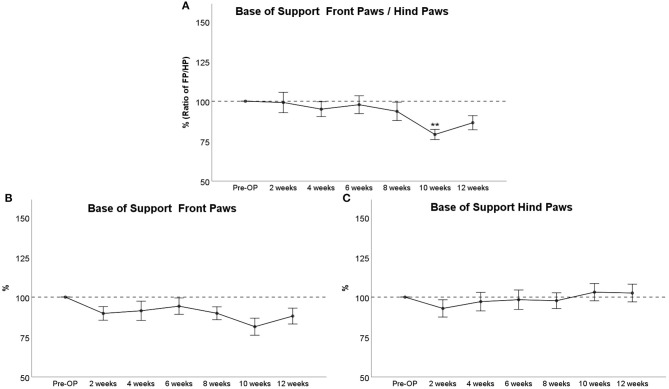
Course of Base of Support (BoS) prior to and following bilateral median nerve resection and unilateral autograft repair. The figures depict either the BoS Ratio between front paws and hind paws (A), the course of front paw BoS (B), or hind paw BoS (C), **p < 0.01 as compared to Pre-OP.